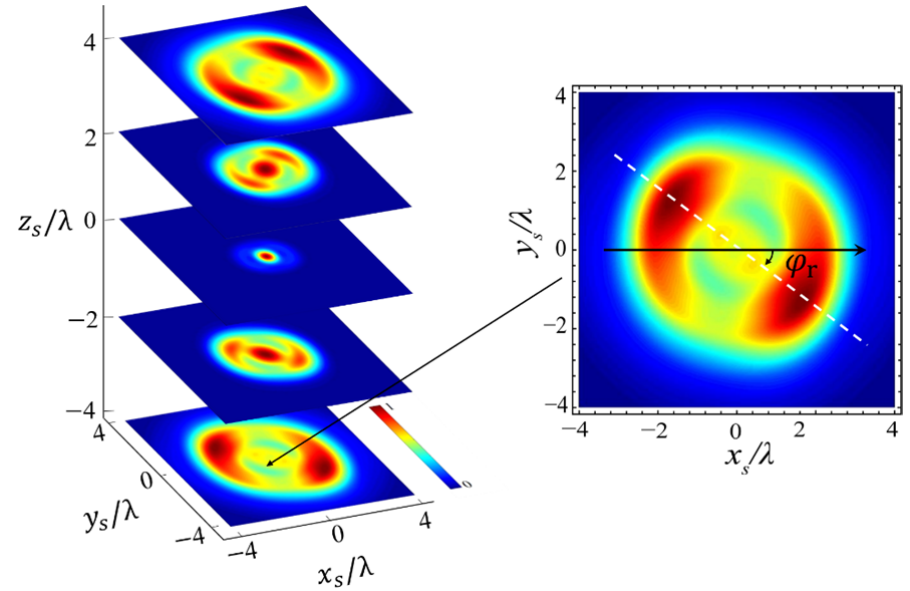
Figure 3. Definition of a rotational angle ϕ r . Here, σ c = 0.5, l = 1, z s = −